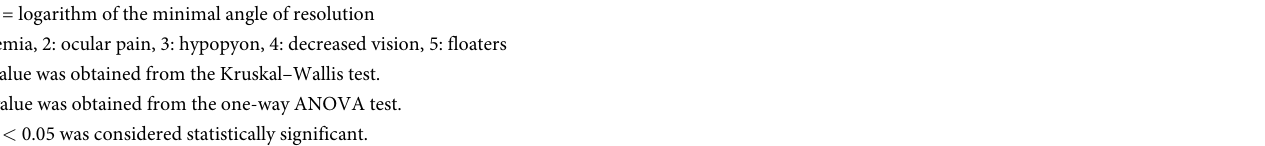
treated with intravitreal antibiotics injection. The other demographic data are shown in Table 4.